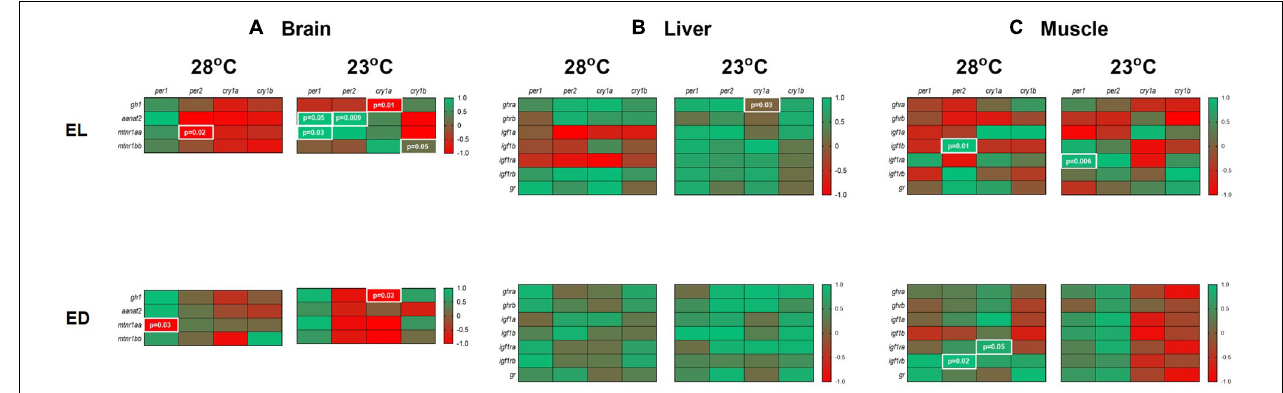
FIGURE 8 | Correlation of gene expression in the brain, liver and muscle of adult Danio rerio . (A) Brain. Four positive and four negative correlations; (B) liver. One positive correlation; (C) muscle. Four positive correlations. Data from the same sample, temperature and time point with a Gaussian distribution were analyzed by Pearson correlation coefficients. The values are expressed as coefficient r . Values: 1 perfect correlation; 0 to 0.99 the two variables tend to increase or decrease together; 0 the two variables do not vary together at all; 0 to –0.99 one variable increases as the other decreases and –1 as perfect negative or inverse correlation. Significance was set for p < 0.05, shown in white letters inside white boxes.